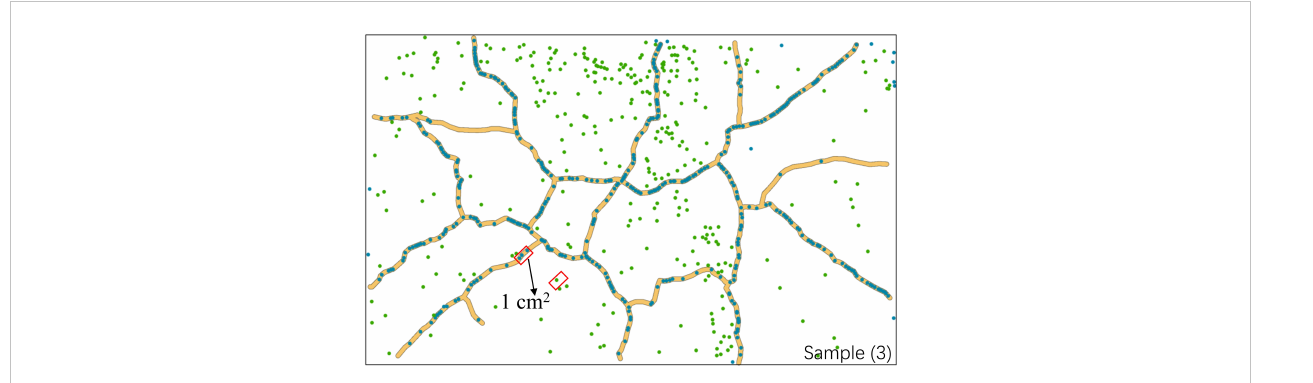
FIGURE 8 Variations in seedling densities between mud cracks and patches. The area marked in red represents one square unit (1 cm 2 ). The image is from parallel sample